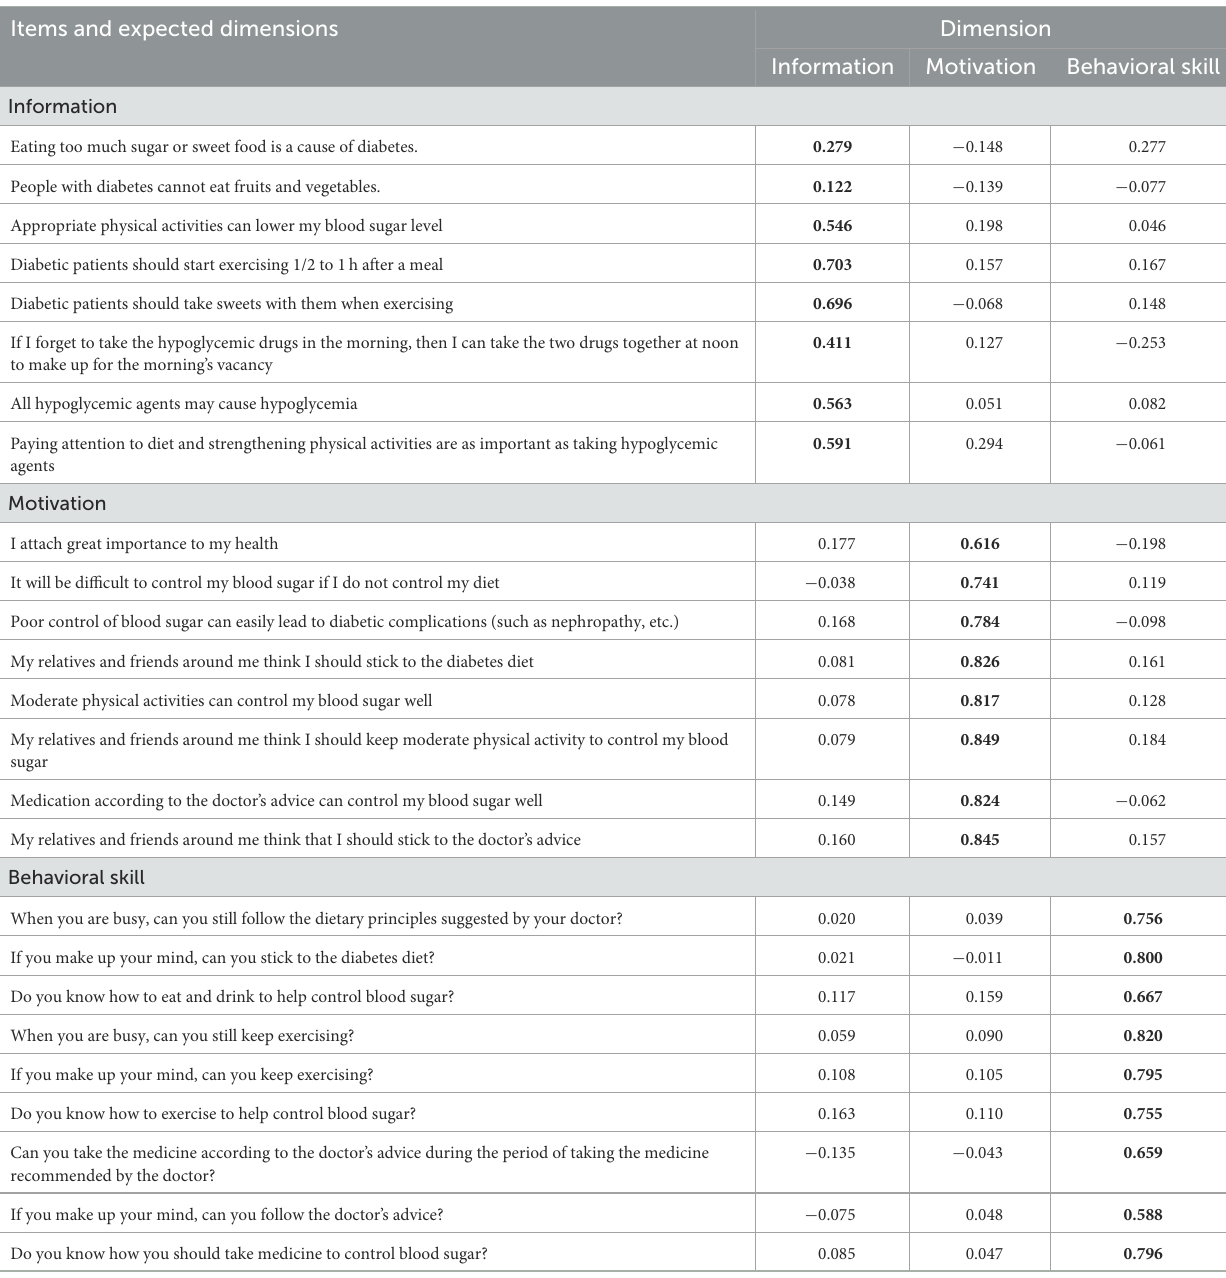
TABLE 2 Factor loadings of 25 items in the preliminary DSMS ( n = 234). Items and expected dimensions Dimension